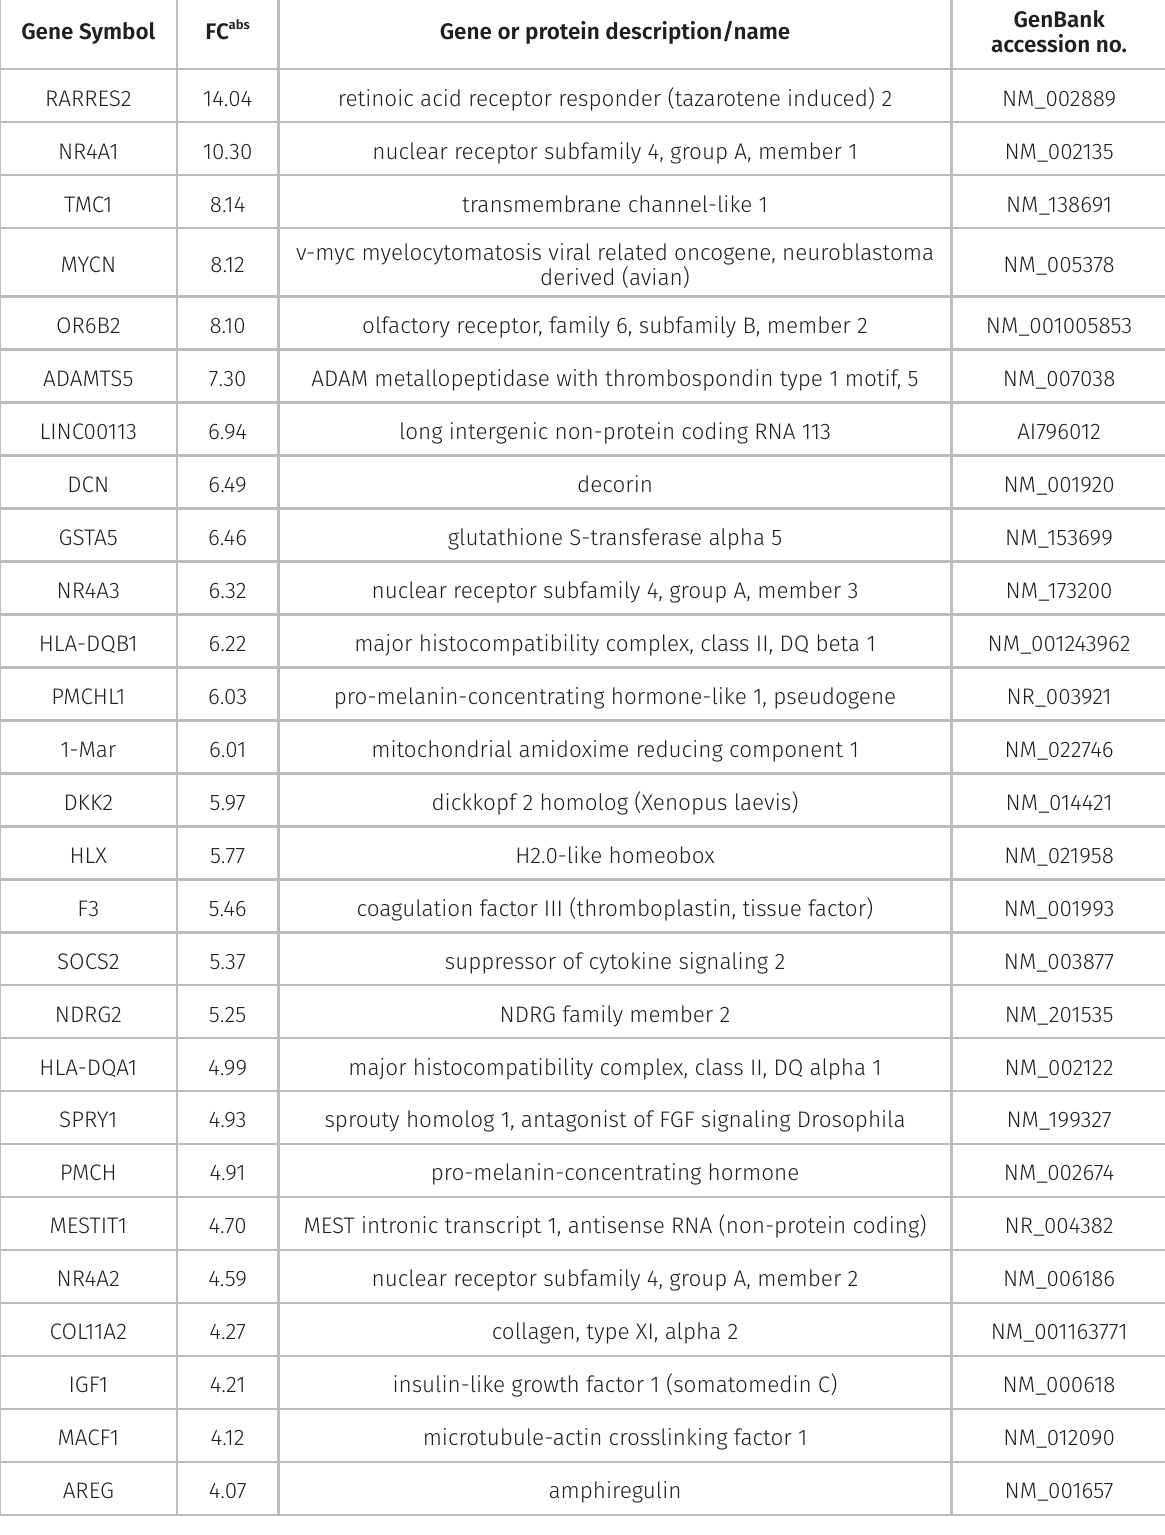
Table II. Top differentially expressed genes of HBMECs after infection with Treponema pallidum for 4 h. Gene Symbol FC abs Gene or protein description/name